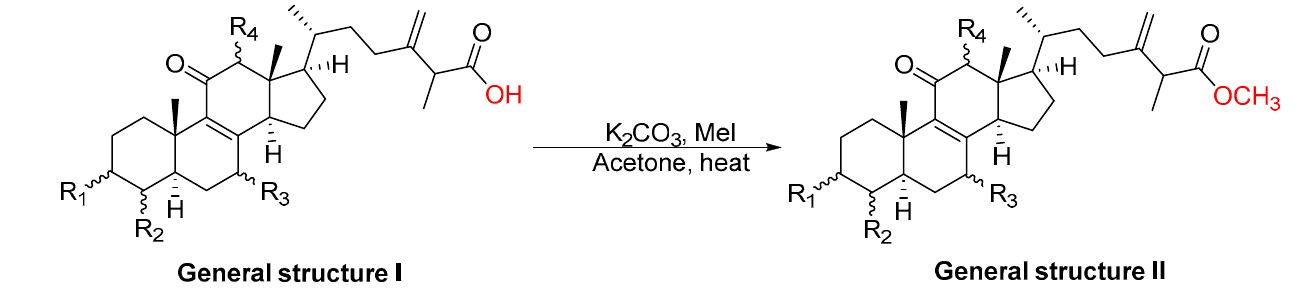
Table 2. Cytotoxicity IC 50 of 5 – 28